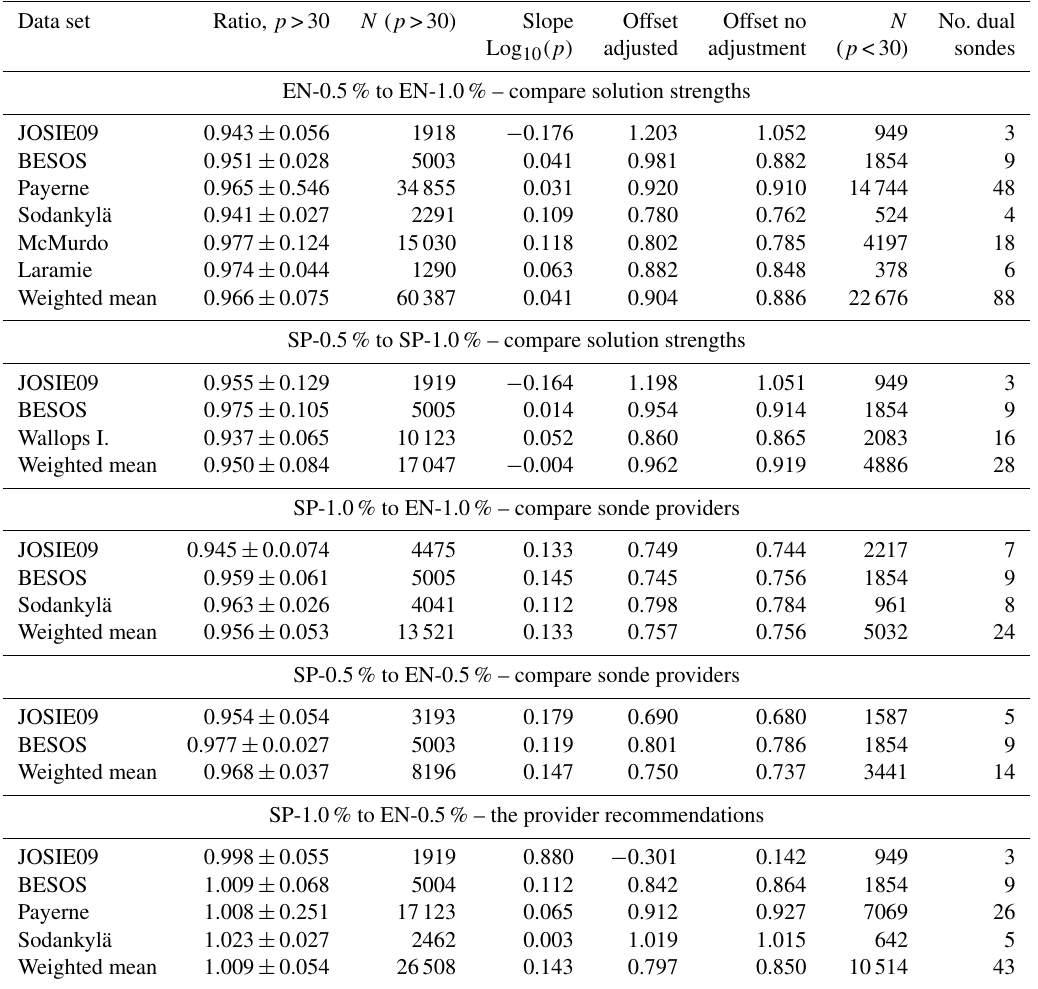
Table 3. Transfer function parameters summary. The second and third columns are for p ≥ 30hPa providing the ratio and number of data points. Columns 4–7 are for p <30hPa, providing the slope of a linear fit in log 10 (p) , the offset adjusted to match the ratio at 30hPa, the offset without constraint to the data below, and the number of data points. The offset is the value of the ratio at p = 1hPa. The final column is the number of dual-sonde measurements for each data set for each application.